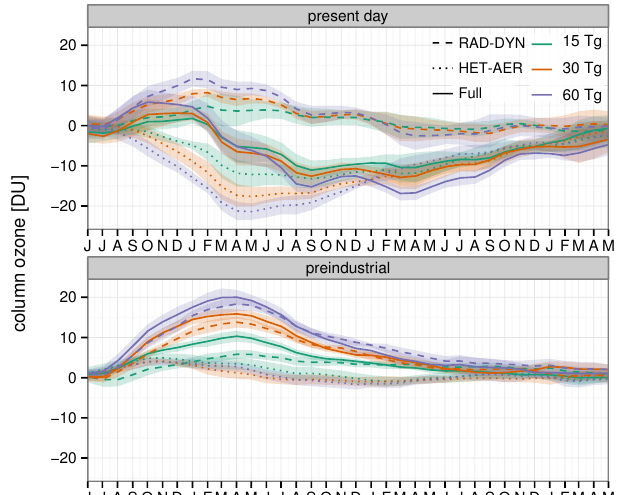
Figure 2. Monthly mean global mean anomalies of column ozone (DU) for present-day (top) and preindustrial conditions (bottom) for the ensemble simulations with the full forcing effect (full, solid lines), the ensemble simulations considering only the heterogeneous aerosol chemical effect of the aerosols (HET-AER, dotted lines), and the simulations forced only by the radiative-dynamical aerosol effects (RAD-DYN, dashed lines). The different eruption sizes are indicated by colours. Lines denote the ensemble mean, shading the standard deviation of the